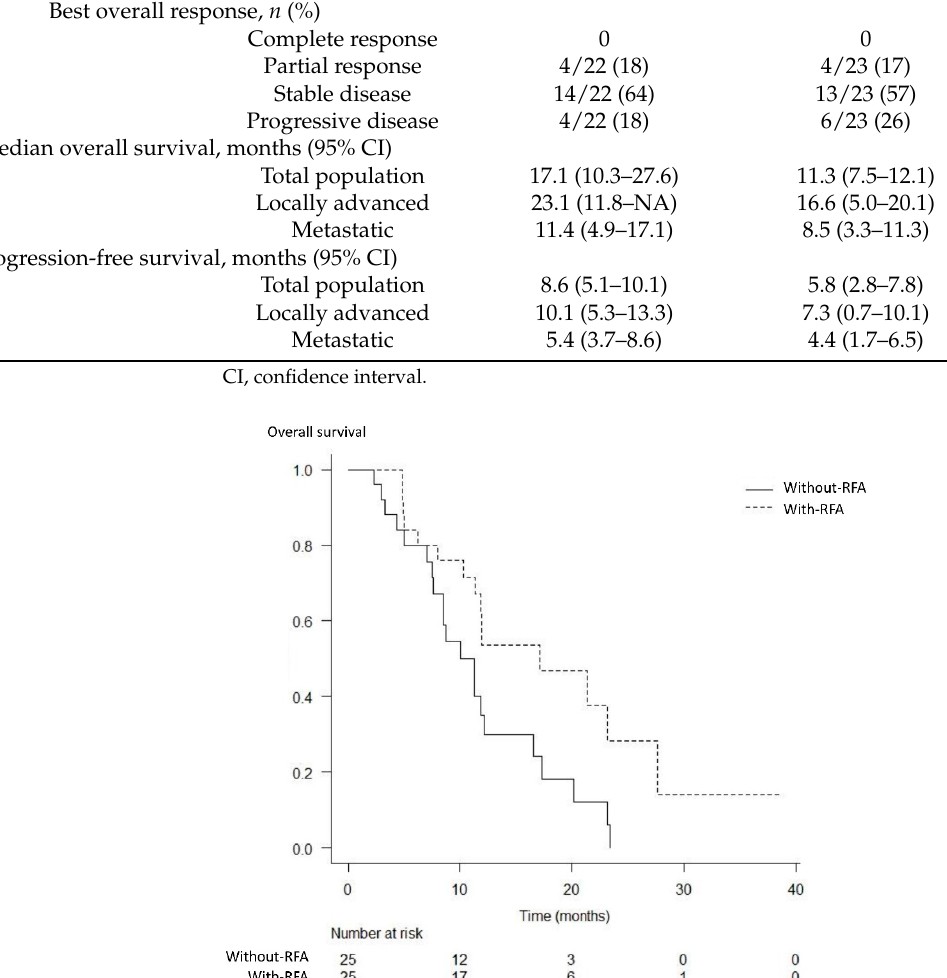
Figure 4. Kaplan–Meier analysis of the progression-free survival. The median progression-free sur- vival was significantly higher in the with-RFA group than that in the without-RFA group (8.6 months versus 5.8 months, p = 0.014).